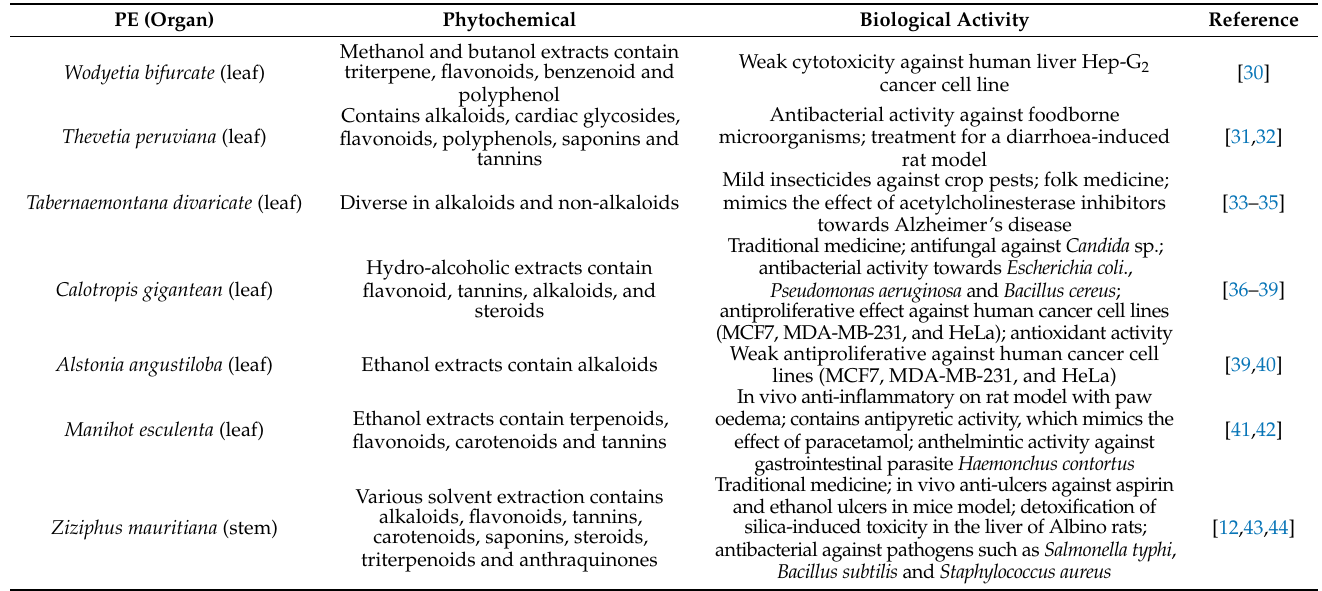
Table 1. Phytochemical profiles and previously reported biological activities of seven PEs were identified from the CLS assay. PE